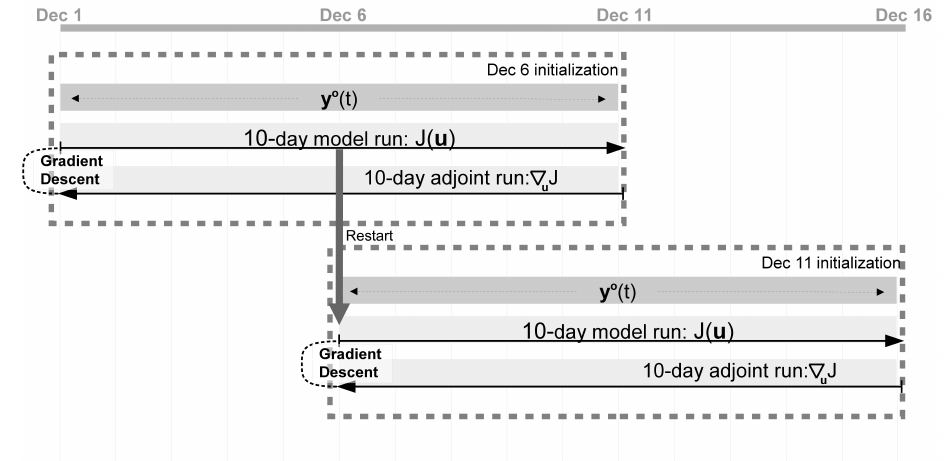
Figure 13. Data assimilation cycle in Hoteit et al. (2009). The pair of direct model run and adjoint model run is repeated iteratively until the predefined convergence criteria is reached. After convergence, the solution at the center of the assimilation period is used as the restart point for the next assimilation cycle: overlap of 5 days.